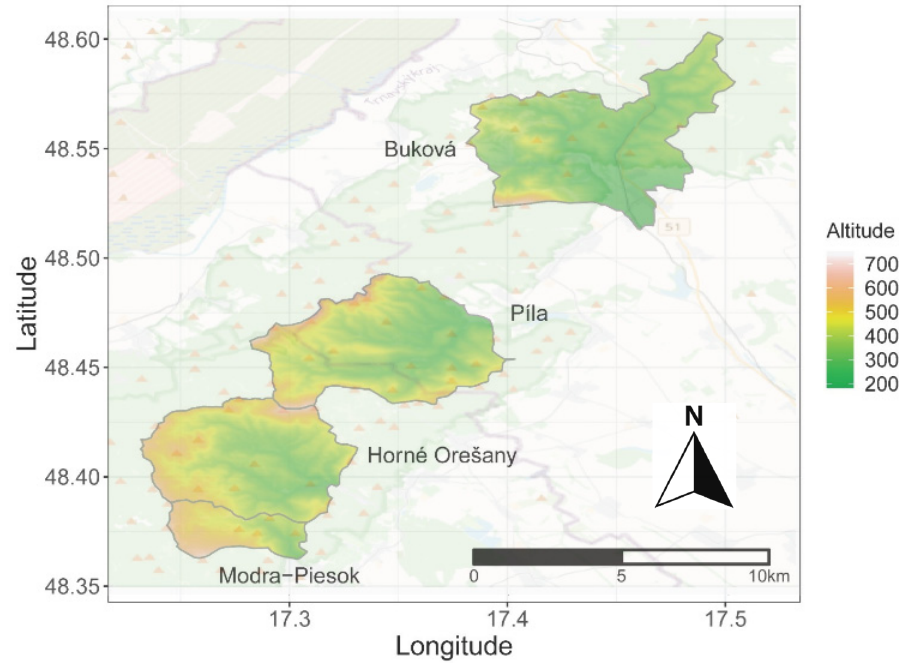
Figure 3. Digital elevation models used for the analyses of the catchments. The lowest and highest altitudes were found in the Buková catchment at 195.3 m above sea level and 738.4 m above sea level, respectively (Table 3). Compared to the other catchments, Bukov á ’s median elevation was relatively low, and its elevations also included the highest number of outliers; see Figure 4. Additionally, the Modra-Piesok catchment had the highest median altitude and deviated from the other catchments’ altitude conditions. other analyzed catchments (and are penalized in Table 6). Table 3. Statistical characteristics describing the catchments’ topographical